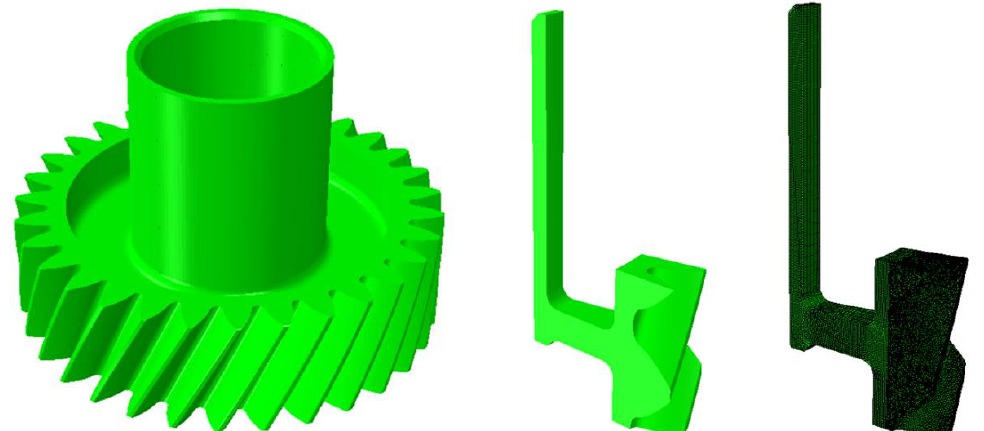
Figure 3. A 3D model of the weight reduced gear ( left picture ), one tooth model ( middle picture ), and the one tooth meshed model ( right picture ) [23].